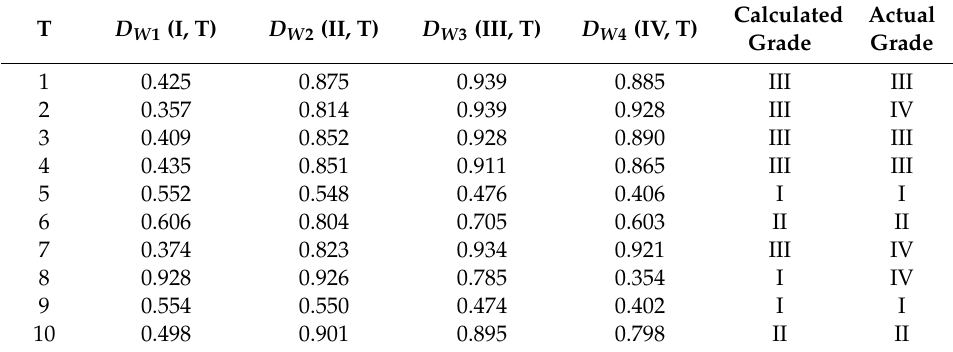
Table 8. The calculated stability grades for the slopes of group B using weight vectors determined by three samples.